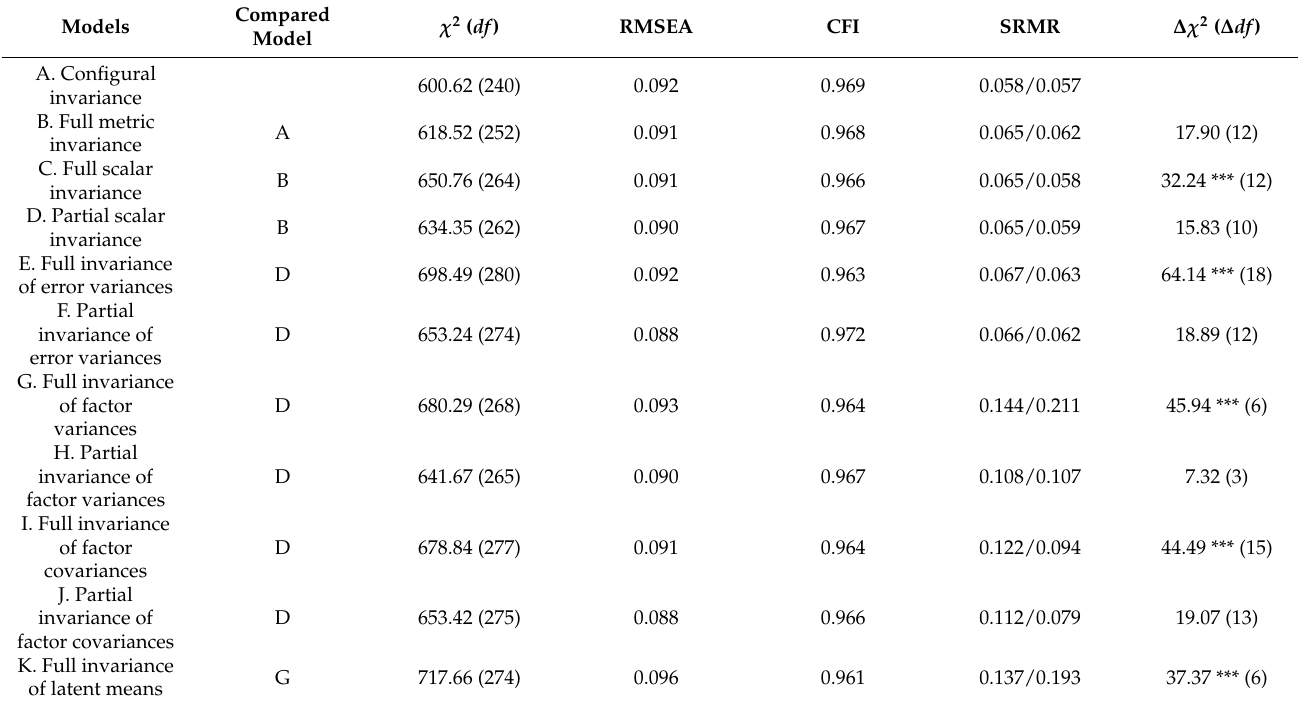
Table 2. Tests of factorial invariance of the psychological well-being scale between women with and without breast cancer ( n =